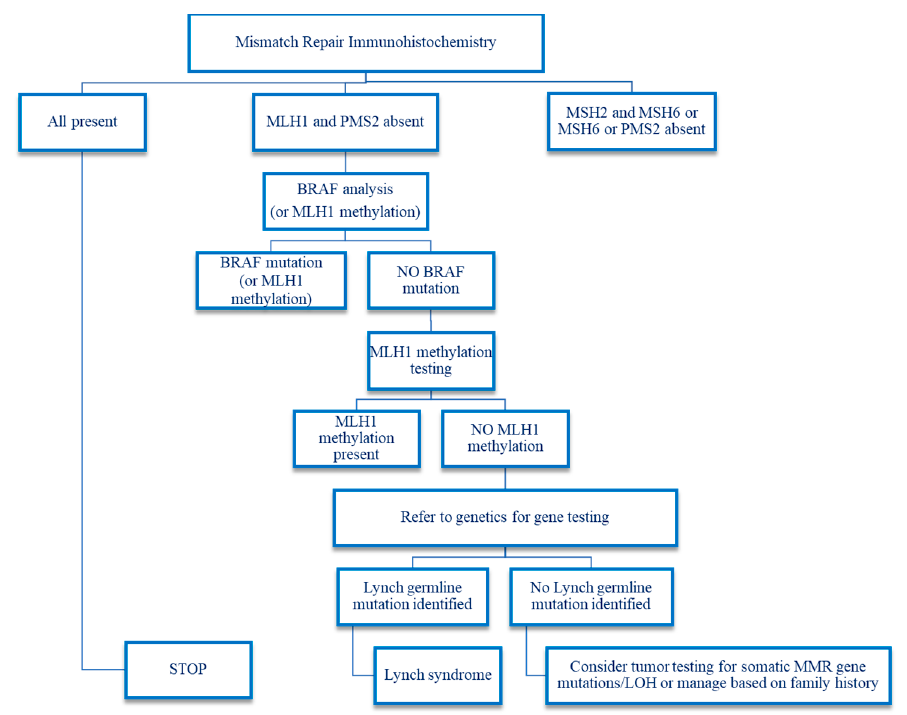
Figure 2. Algorithm for MLH1 methylation and BRAF analyses in dMMR/MSI-H CRC. Modified from Chen W. et al. [24].